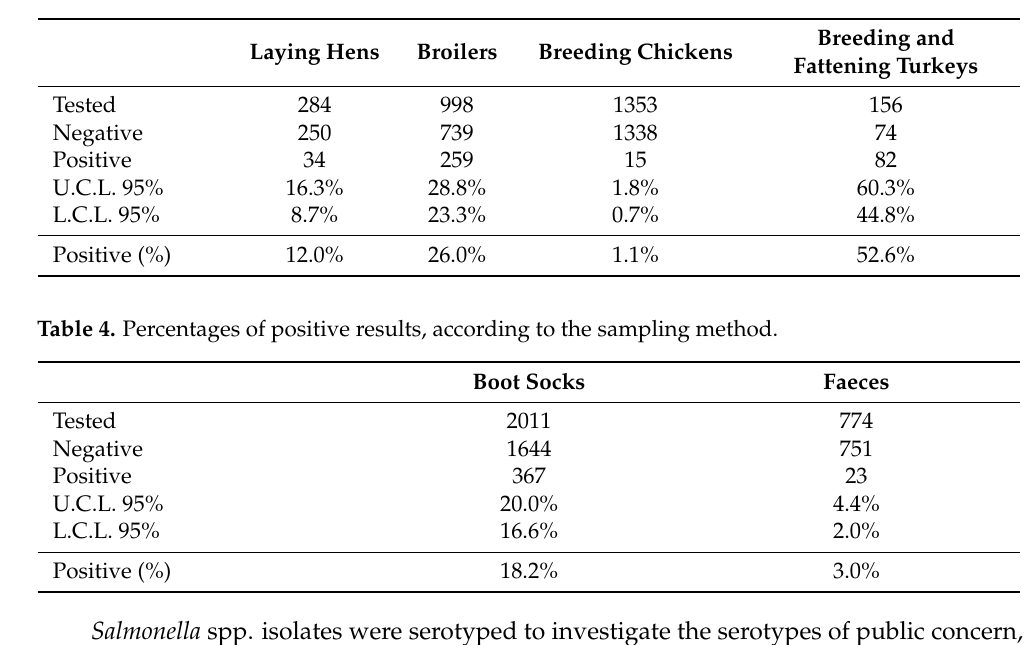
Salmonella spp. isolates were serotyped to investigate the serotypes of public concern, and 393 serotypes were identified. In particular, two serotypes were isolated in a boot sock sample and three serotypes in another boot sock. Salmonella enterica subsp.